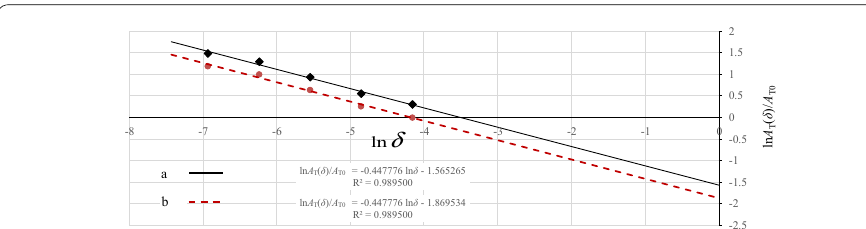
Fig. 12 Comparison diagram of the same fractal dimensions but